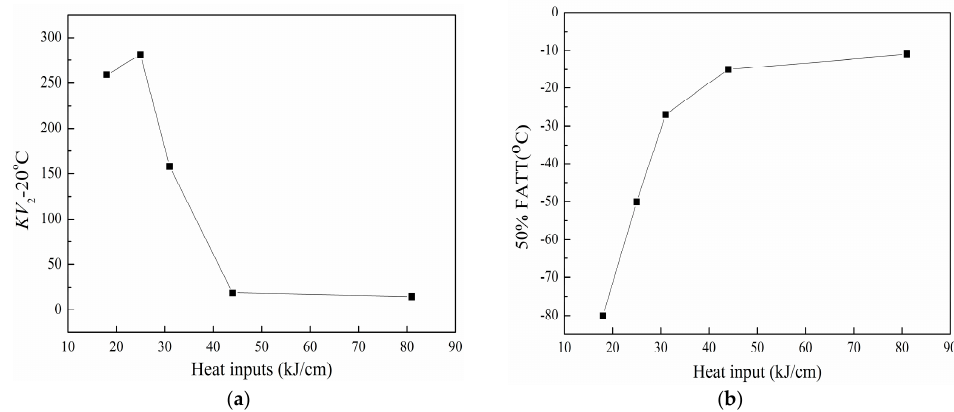
Figure 14. The impact toughness at − 20 °C and 50% FATT curve of the simulated CGHAZ in the experimental steels subjected to different heat inputs. ( a ) Impact toughness at − 20 °C; and ( b ) 50% FATT.